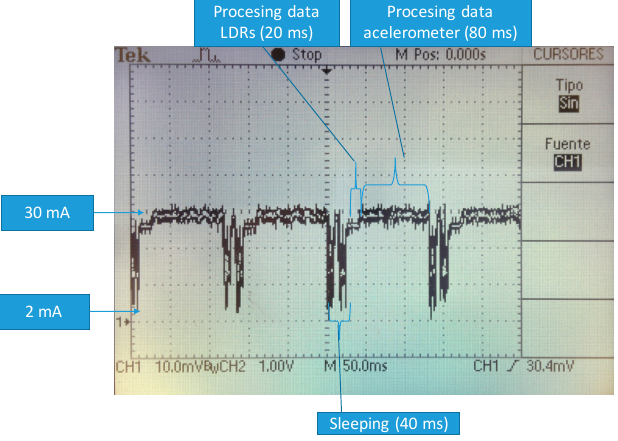
Figure 13. Time variability of energy consumption.